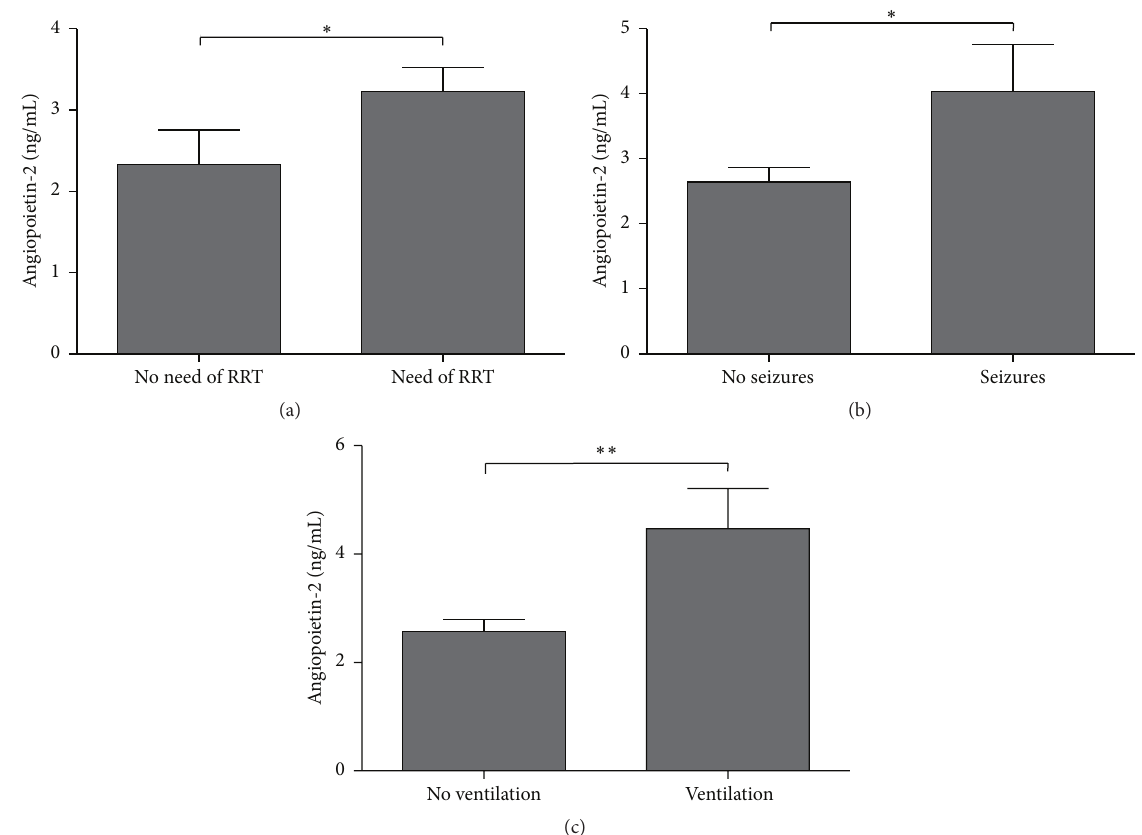
Figure 1: Association of Angpt-2 levels on day three after admission with clinical complications. Boxplots showing associations between Angpt-2 levels and clinical outcomes ((a) need of RRT, (b) occurrence of seizures, and (c) need of mechanical ventilation); ∗ 𝑝 < 0.05 and ∗∗ 𝑝 < 0.01